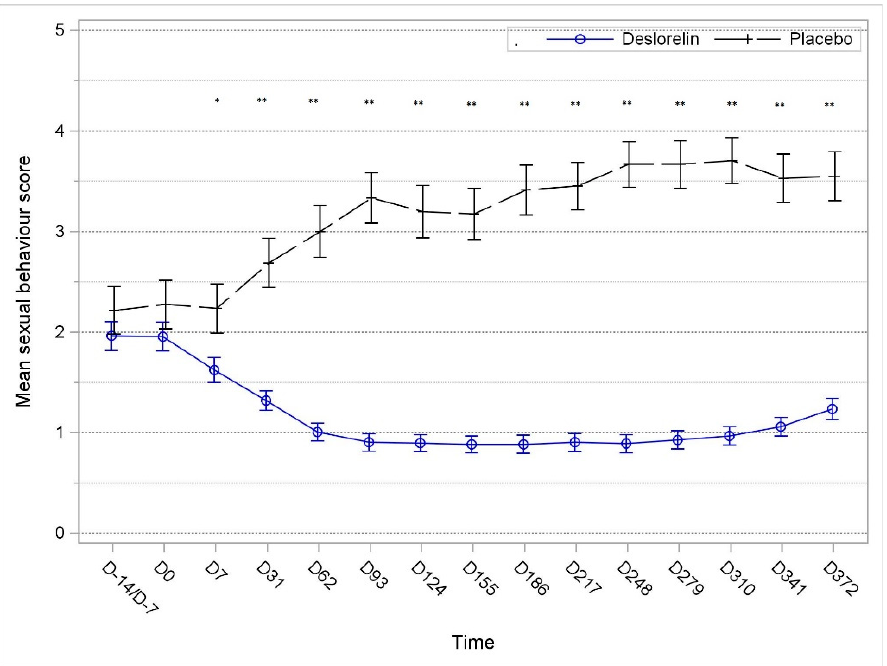
Figure 2. Course of mean sexual behavior score (expressed as mean ± SE) in the deslorelin and control groups over time. * Significant difference ( p = 0.013) between groups. ** Significant difference from D31 onward ( p < 0.001).